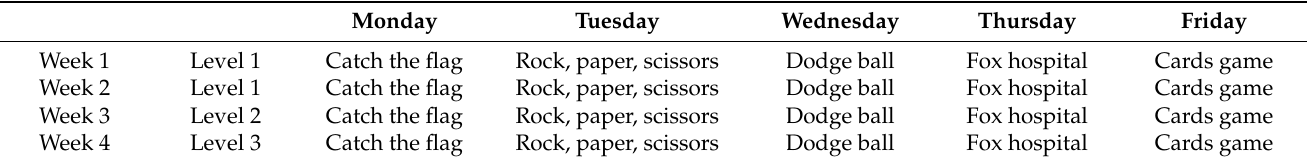
Table 1. Distribution of the contents of the sessions per day during the 4 weeks of